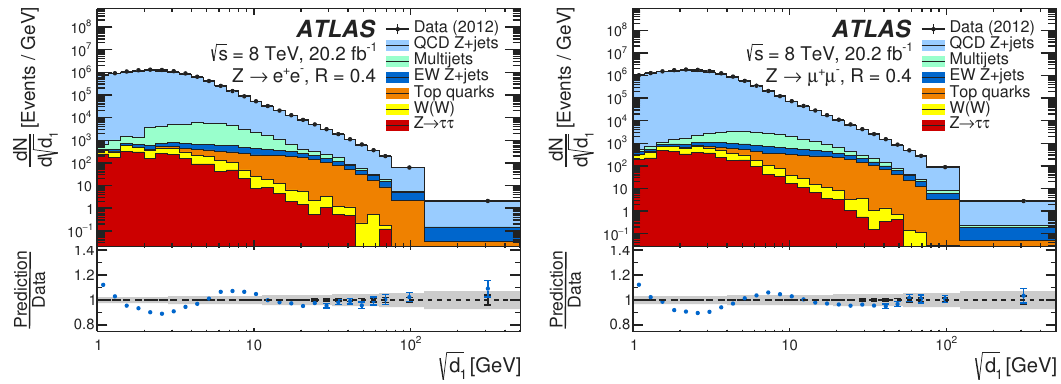
Figure 2. Detector-level splitting scale distributions in the electron and muon channels using the jet-radius parameter R = 0 : 4. The lower panel shows the ratio of the combined Monte Carlo predictions to the data. The size of the error bars re(cid:13)ects the statistical uncertainty for predictions and data, while the combined experimental and systematic data uncertainty is indicated by a grey band around